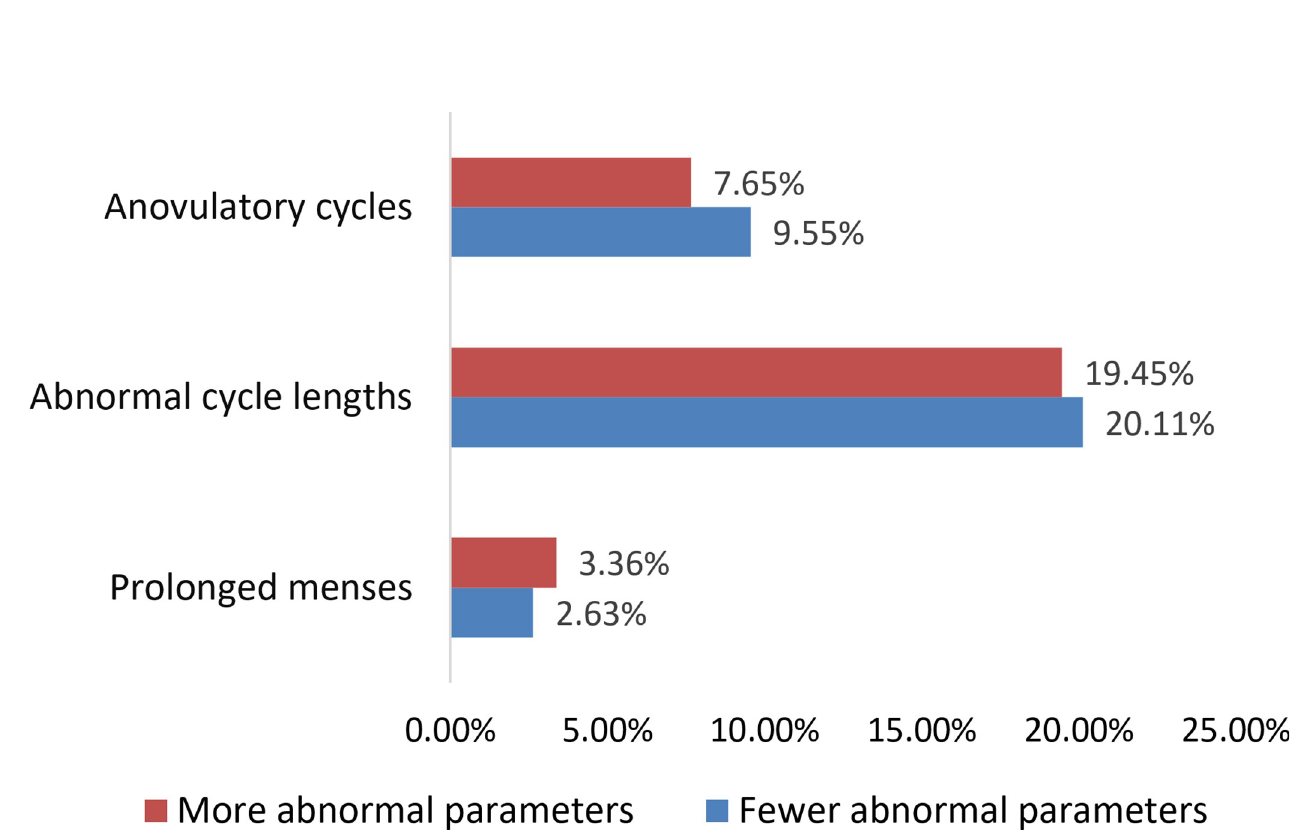
Fig 1. Changes in the proportion of abnormal menstrual cycle parameters among users reporting more stress during than prior to the COVD-19 pandemic (n =